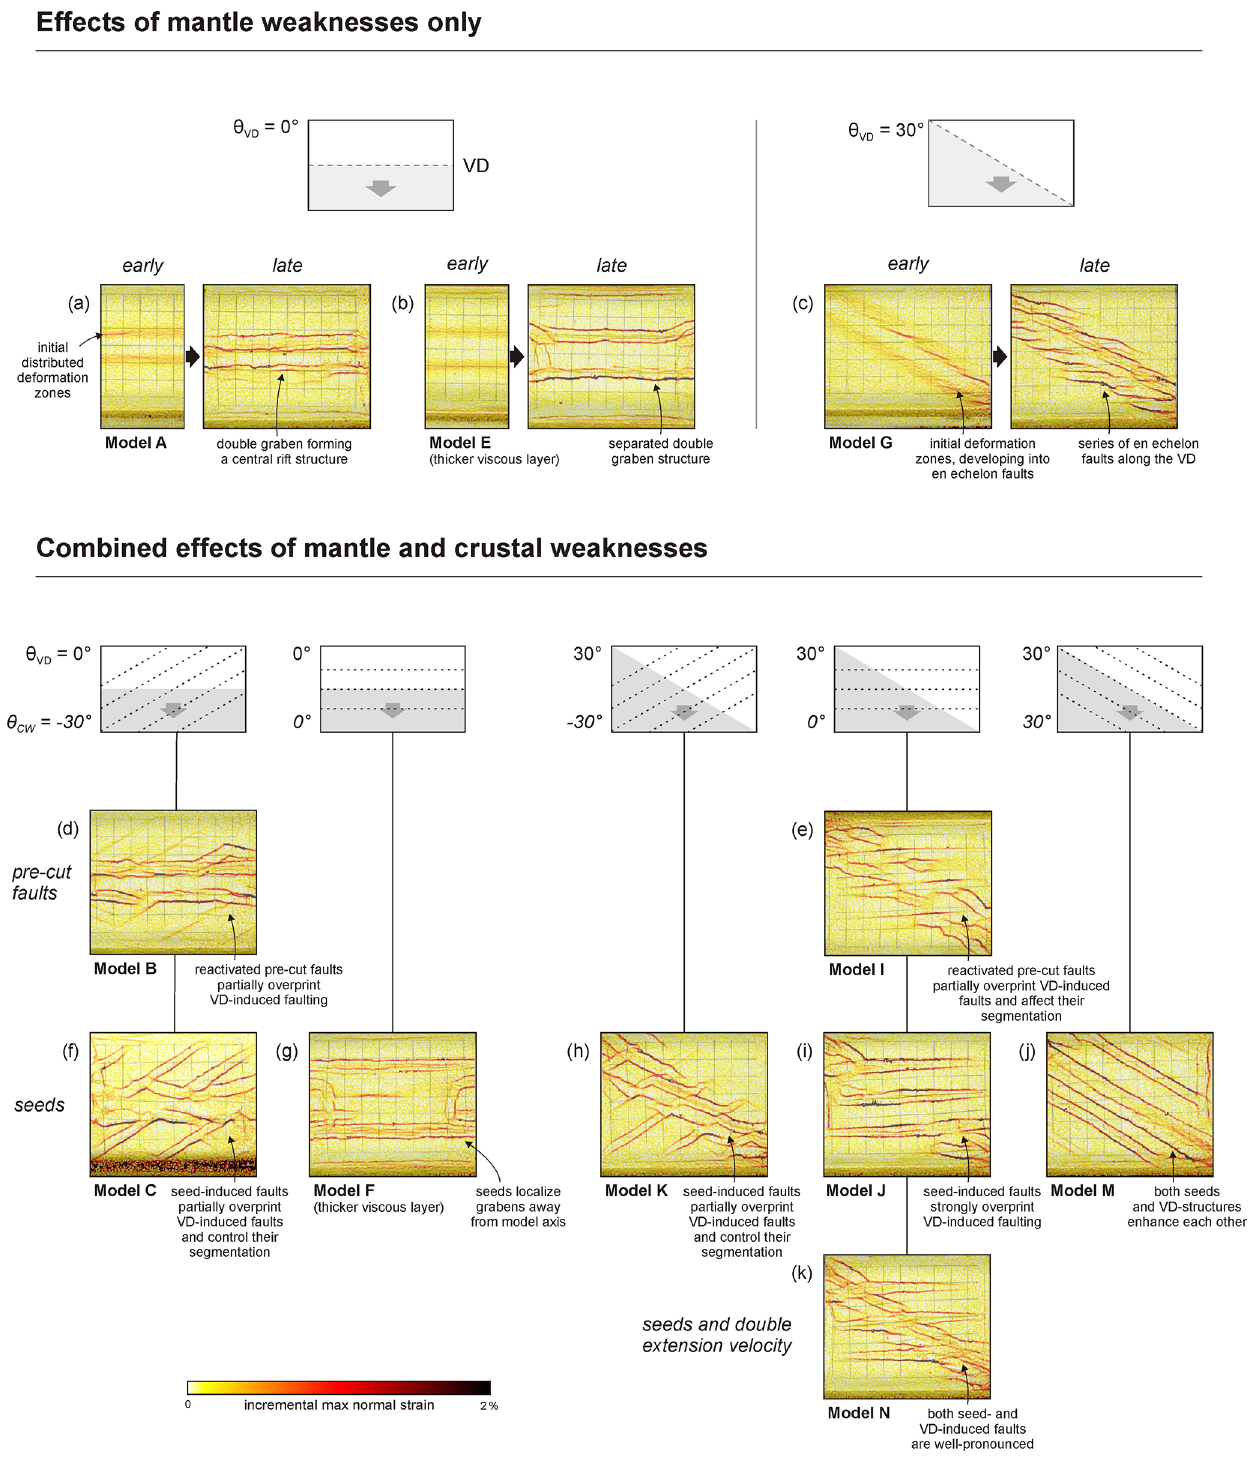
Figure 11. Summary of model results (PIV-derived incremental maximum normal strain) as a function of mantle discontinuity geometry, as well as type and geometry of crustal weakness, and extension velocity. The top views represent the incremental deformation during the final model stage ( e = 10%), as well as during the initial model stage ( e = 1 . 6%) in (a–c) . Angle θ VD provides the orientation of the VD (velocity discontinuity, representing a mantle weakness), whereas angle θ CW provides the angle of the simulated crustal weaknesses (see Fig. 1c–f for